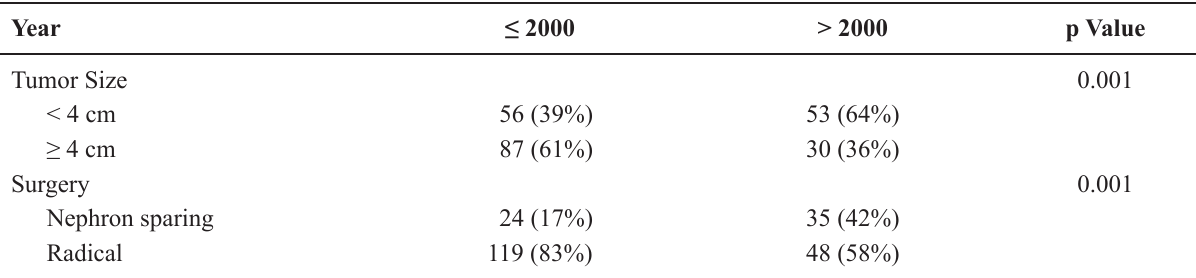
Table 1 – Distribution of kidney tumors before and after the year 2000, regarding tumor sizes and the type of surgery